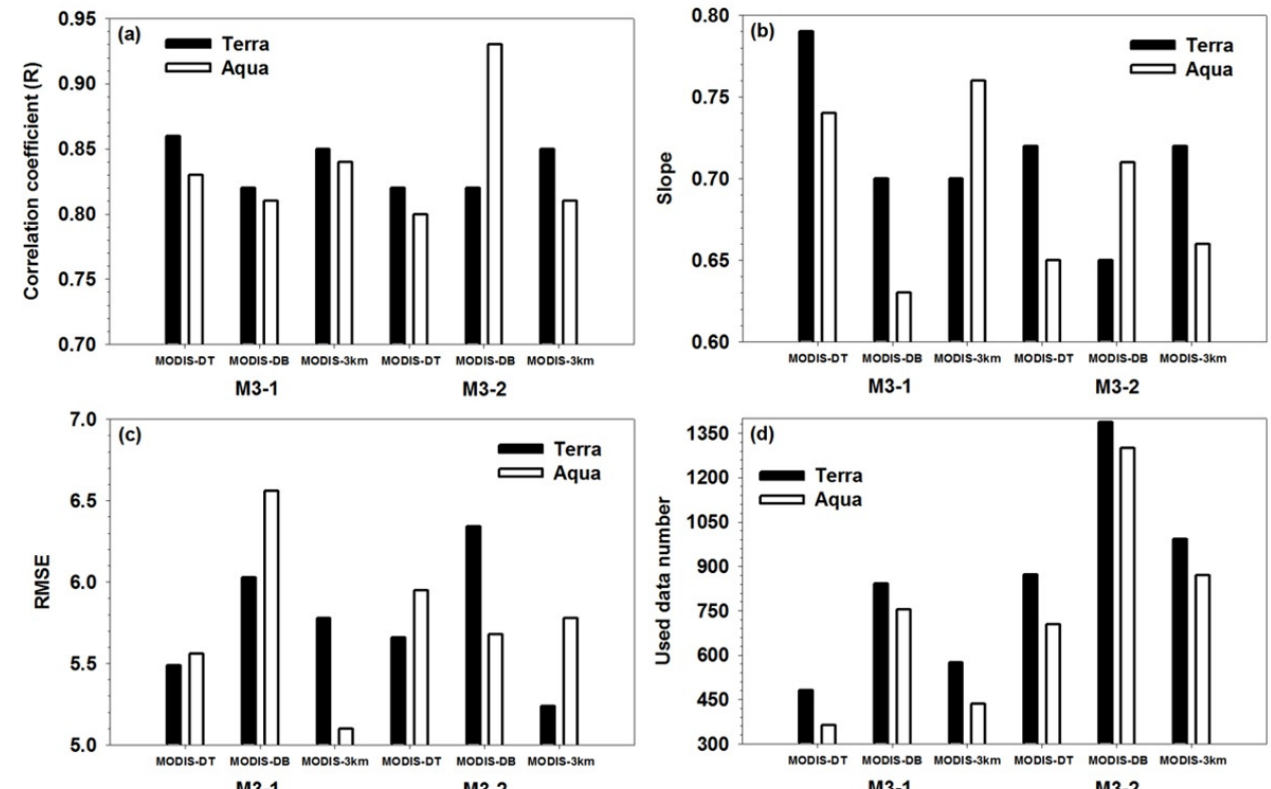
Figure 3. Provision of ( a ) R, ( b ) slope, ( c ) RMSE, and ( d ) number of data used for the comparison between measured and estimated PM2.5 from M3-1 and M3-2 models with the usage of MODIS-DT, MODIS-DB, and MODIS-3km AODs. Black bars indicate results from AODs of the Terra satellite, and white bars indicate results from AODs of the Aqua satellite. The unit of RMSE is μ g/m 3 .